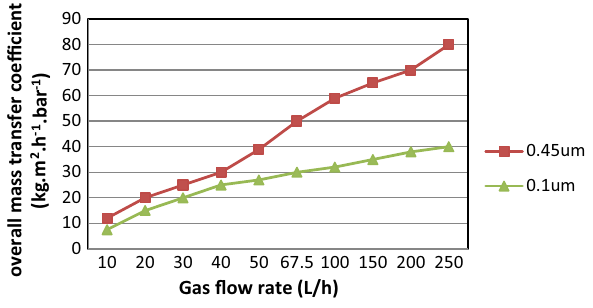
Fig. 12 Effect of gas flow rate on the overall mass transfer coefficient in SGMD. as the sweeping gas; inlet gas temperature 21 °C; evapora- tion temperature 45 °C; liquid flow rate 20 l/h; gas side pressure 0; liquid side pressure 13.8 kPa